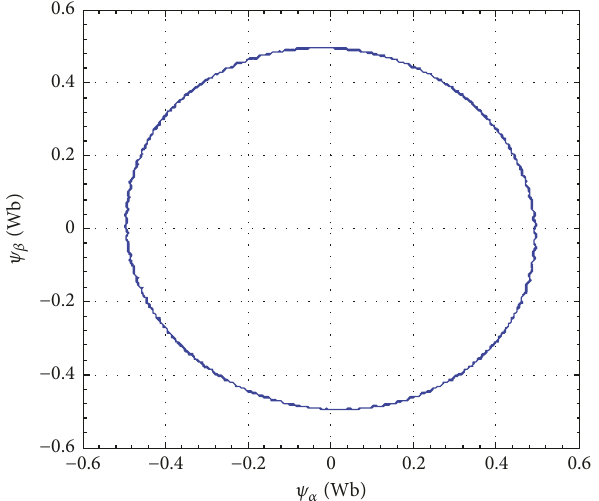
Figure 10: Trajectory of virtual